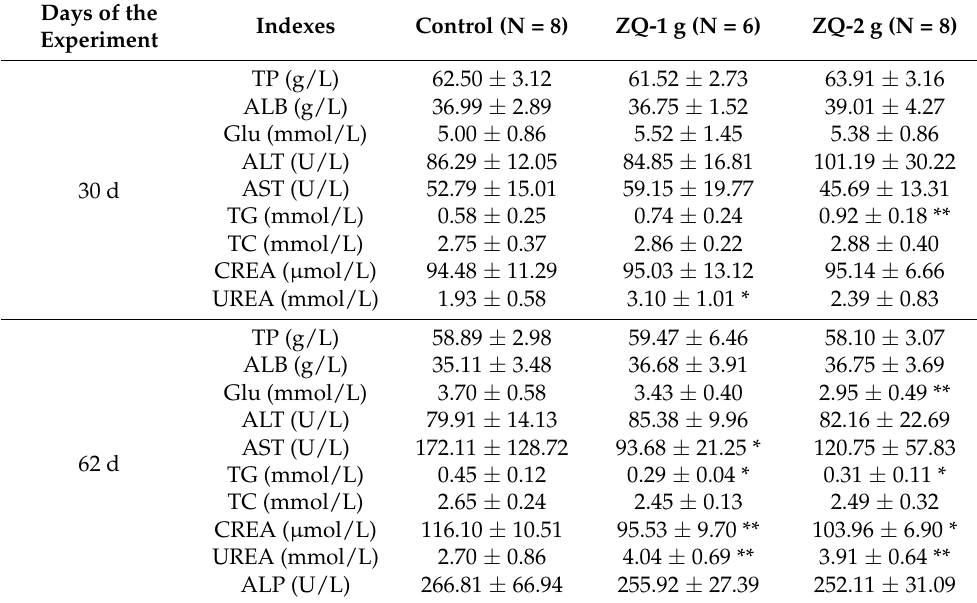
Table 3. Effects of ZQ on the biochemical indices of blood. Days of the